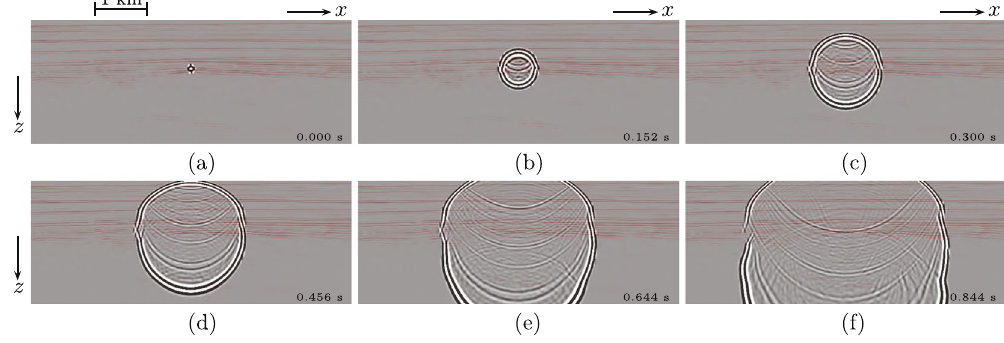
Figure 4. Virtual response G ( r , s , t ) + G ( r , s , − t ), retrieved from the single-sided seismic reflection response G ( x ′ , x , t ) of the Vøring Basin. ( a ) t = 0 ms. ( b ) t = 152 ms. ( c ) t = 300 ms. ( d ) t = 456 ms. ( e ) t = 644 ms. ( f ) t = 844